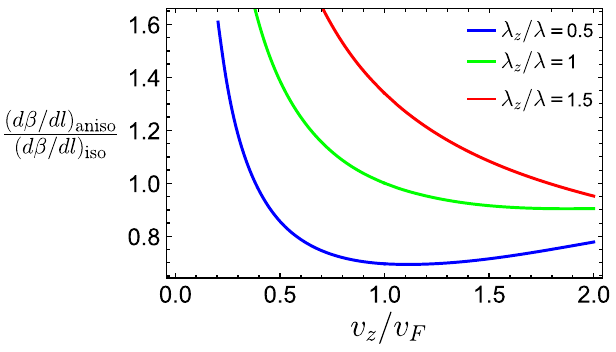
FIG. 7. The β -function for the flow of the dimensionless coupling constant β with the anisotropies, Eqs. (D1) – (D2), normalized by the “ isotropic ” β -function given by Eq. (17), as a function of v z =v F for three different values of λ z = λ